Question: What form of chart is displayed?
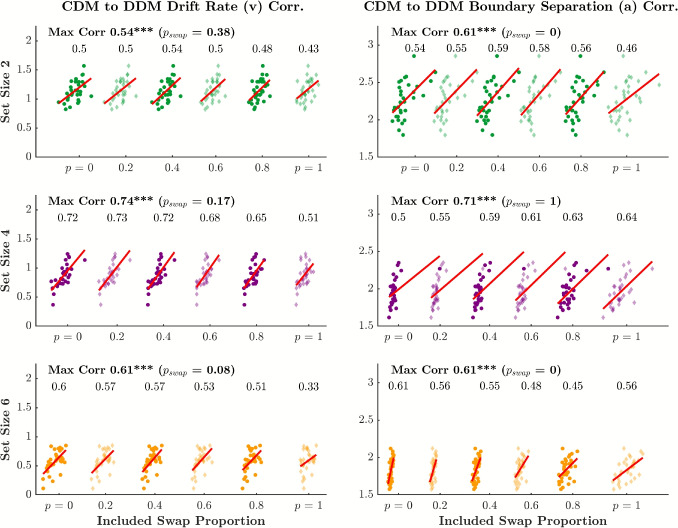
Answer: scatter